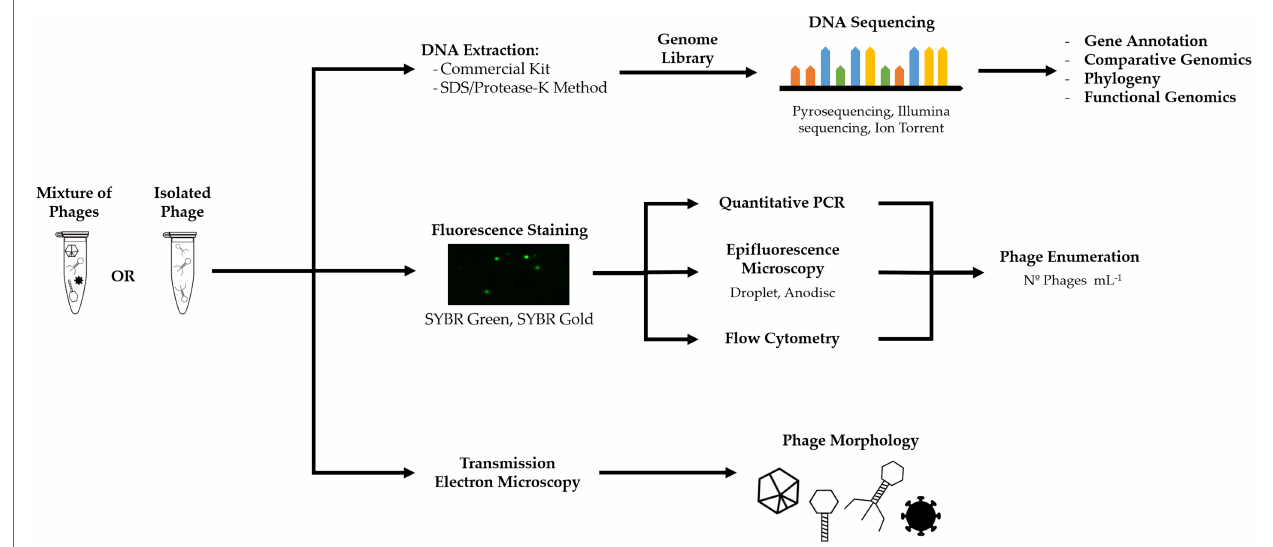
FIGURE 4 | Culture-independent methods, such as metagenomics, fluorescent staining, and electron microscopy, can yield information on phage genome, infection and life cycle, phage concentration, and